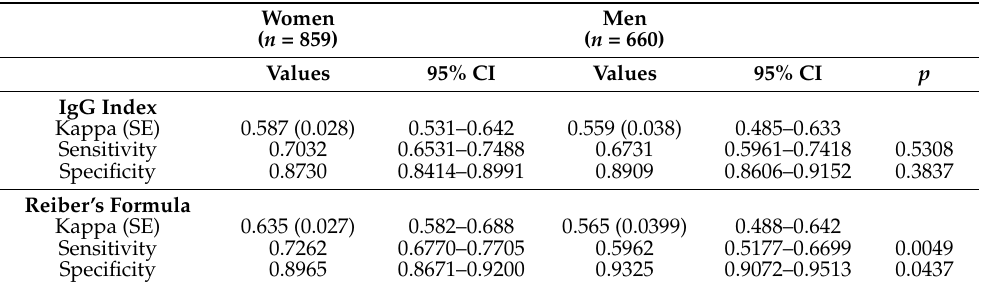
Table 2. Agreement between the mathematical formulas and the “gold standard” of OCBs determi- nation in evaluating the presence of an intrathecal IgG